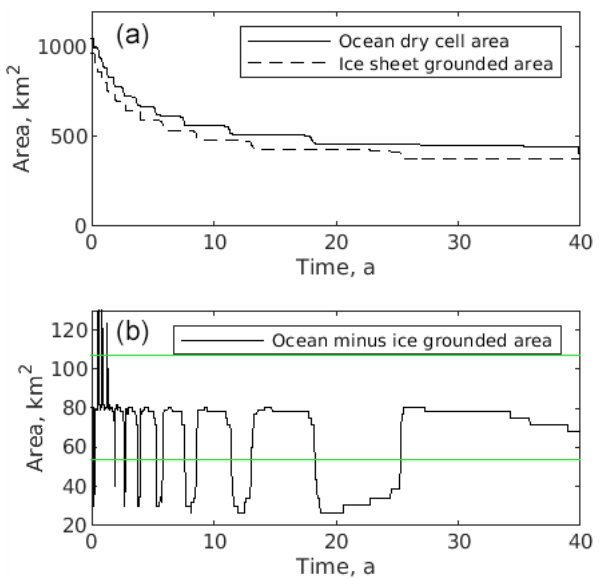
Figure 9. (a) A comparison of grounded area in the ocean compo- nent (total area of dry elements) against grounded area in the ice component (total area of grounded elements). (b) The difference between ocean and ice grounded area. These are from simulation VE2_EF. The green lines are drawn such that their distance apart is equivalent to the area of one row of ocean